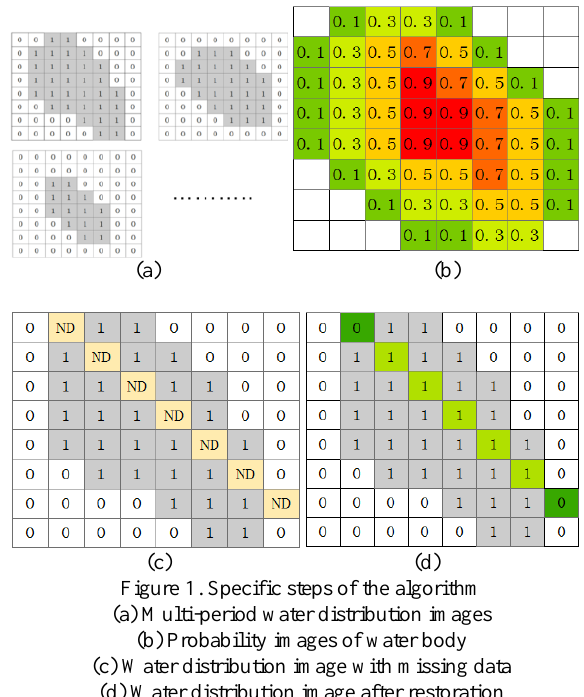
Figure 1. Specific steps of the